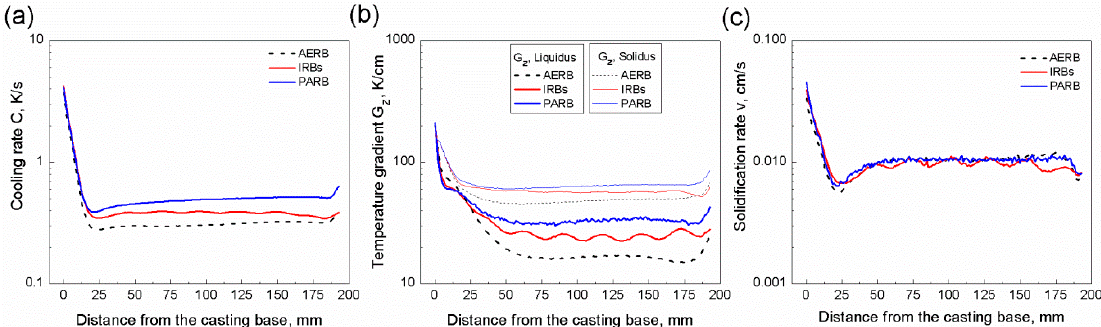
Figure 6. Predicted profiles of cooling rate ( a ), axial temperature gradient ( b ), and solidification rate ( c ) along the symmetry axis of the casting. AERB: adjusted external radiation baffle; IRBs: inner radiation baffles; PARB: perfectly adjusted radiation baffle.